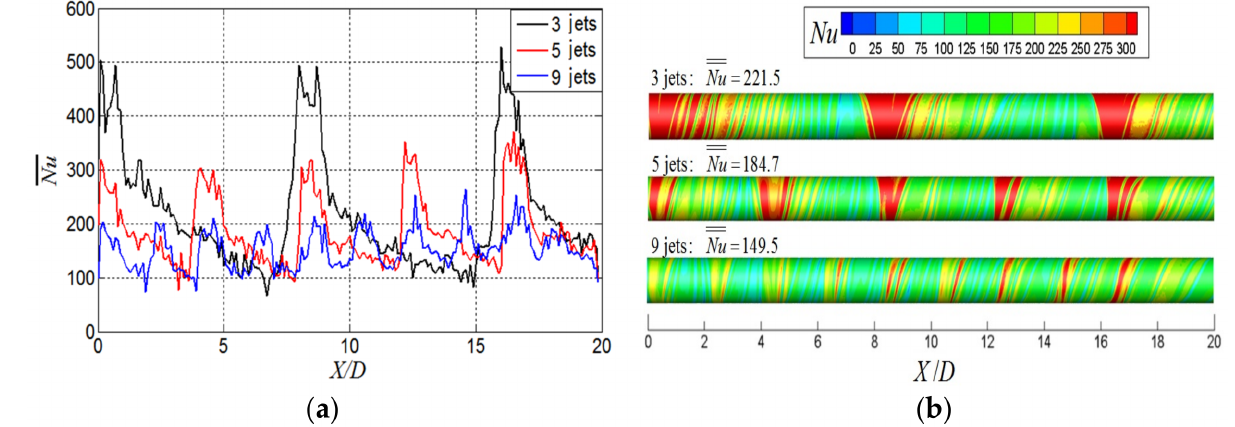
Figure 6. Influence of the jet number on the Nusselt number distribution of a smooth tube at Re D = 50,000: ( a ) Circumferentially averaged Nusselt number; ( b ) Local Nusselt number.